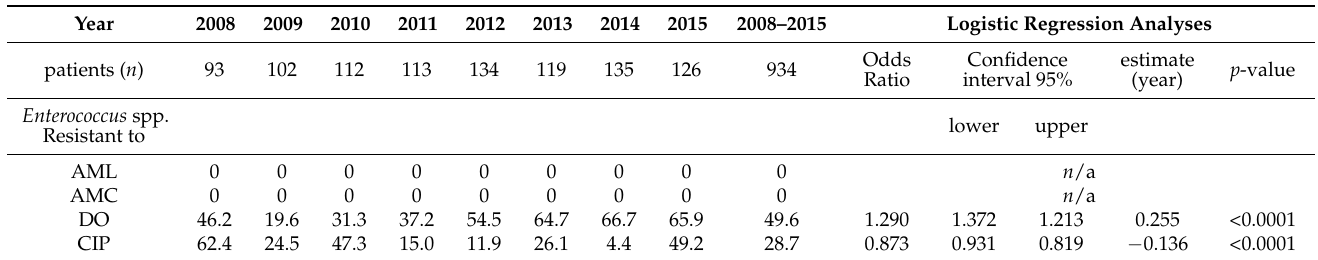
Table 5. Temporal evolution (2008 to 2015) of the occurrence of antibiotic resistances to amoxicillin (AML), amoxicillin/clavulanic acid (AMC), doxycycline (DO), ciprofloxacin (CIP) was analyzed using logistic regression methods. Trend in the occurrence of antibiotic resistances (%) in Enterococcus